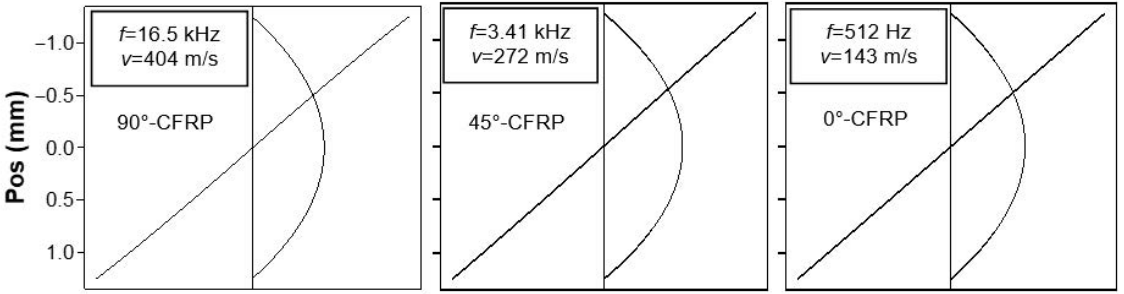
Figure 7. Identical strain distributions with depth calculated for a 0 modes in different directions of UD-CFRP at different frequencies.